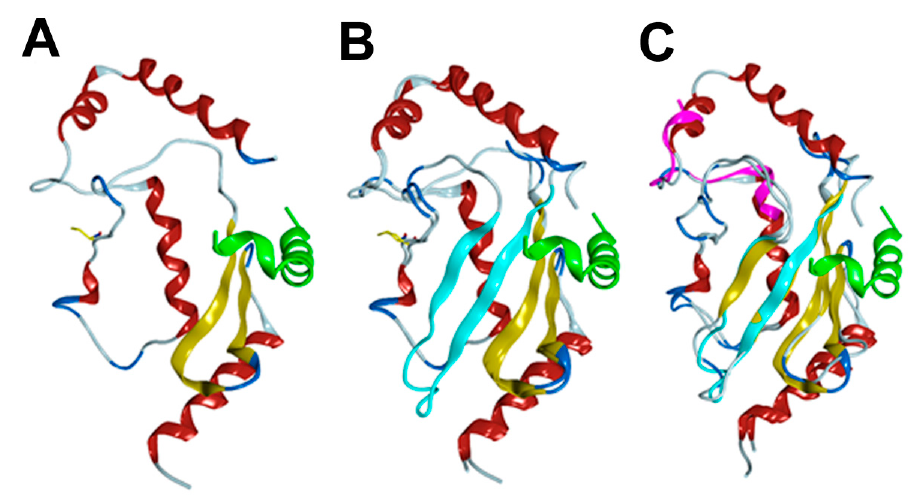
Figure 4. Homology models of RAD6B ∆ exon4 and RAD6Bintron5ins. ( A ) Model of RAD6B ∆ exon4. The catalytic cysteine residue is shown as a yellow line. RAD18 is shown in green. ( B ) Overlay of RAD6B ∆ exon4 and wild-type RAD6B from PDB file 2YBF. Beta sheets 3 and 4 of the wild-type RAD6B are shown in light blue. RAD18 is shown in green. ( C ) Overlay of RAD6Bintron5ins with wild-type RAD6B from PDB file 2YBF. The insertion is shown in magenta.